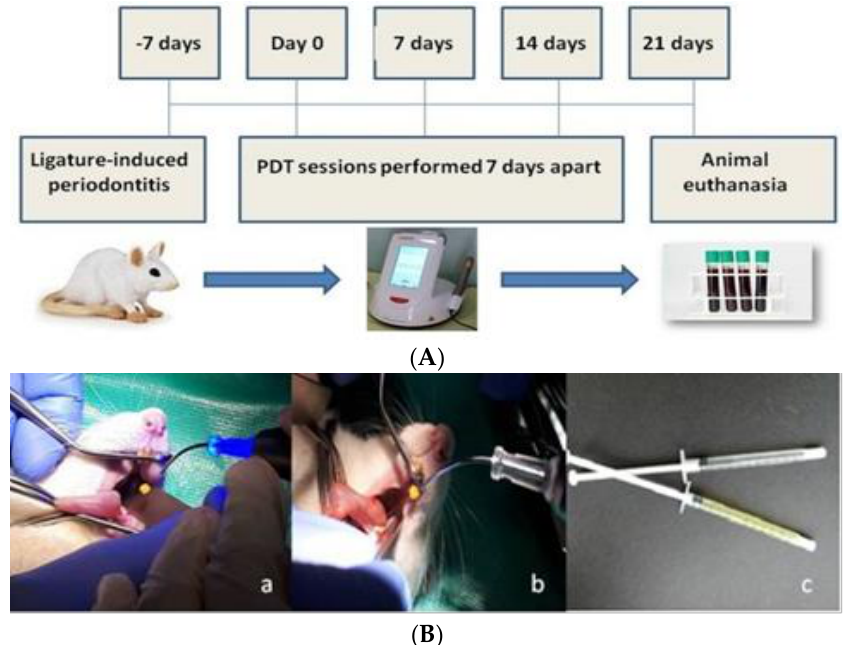
Figure 10. ( A ). The treatment regimen followed in the periodontal disease induced in rats; ( B ) ( a , b ) different stages during aPDT procedure; ( c ) oregano and curcuma-based gels used in the study. Treatment was carried out with the use of low-intensity laser SiroLaser Blue (Sirona, 64625 Bensheim Deutschland) at a wavelength of 445 nm and 200 mW, continuous wave (CW), contact mode, power density 400 mW/cm 2 , using a periodontal tip with 320 µm diameter, attached to the hand piece. In the GC and GO groups, the PS was instilled into the subgingival area with a blunt needle in apical-coronal direction. After 60 s, the PS was rinsed with 1 mL of Kaqun ® water (Harghita, Romania) using a graded syringe. Then in GC, GO and L groups, the laser beams were directed into the pockets for 40 s. Irradiation was maintained for 10 s in 4 equidistant sites (2 vestibular and 2 buccal sites). The pro- cedures were repeated one week apart for 4 weeks (Figure 10A).